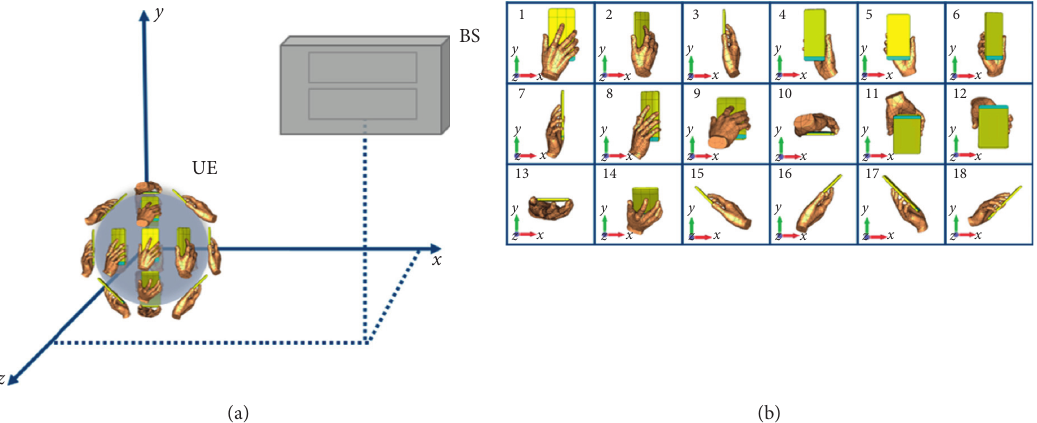
Figure 18: Introducing phone rotation in the system: (a) 3D representation of the rotation modes with relation to the BS; (b) nomenclature for the 18 rotation positions.